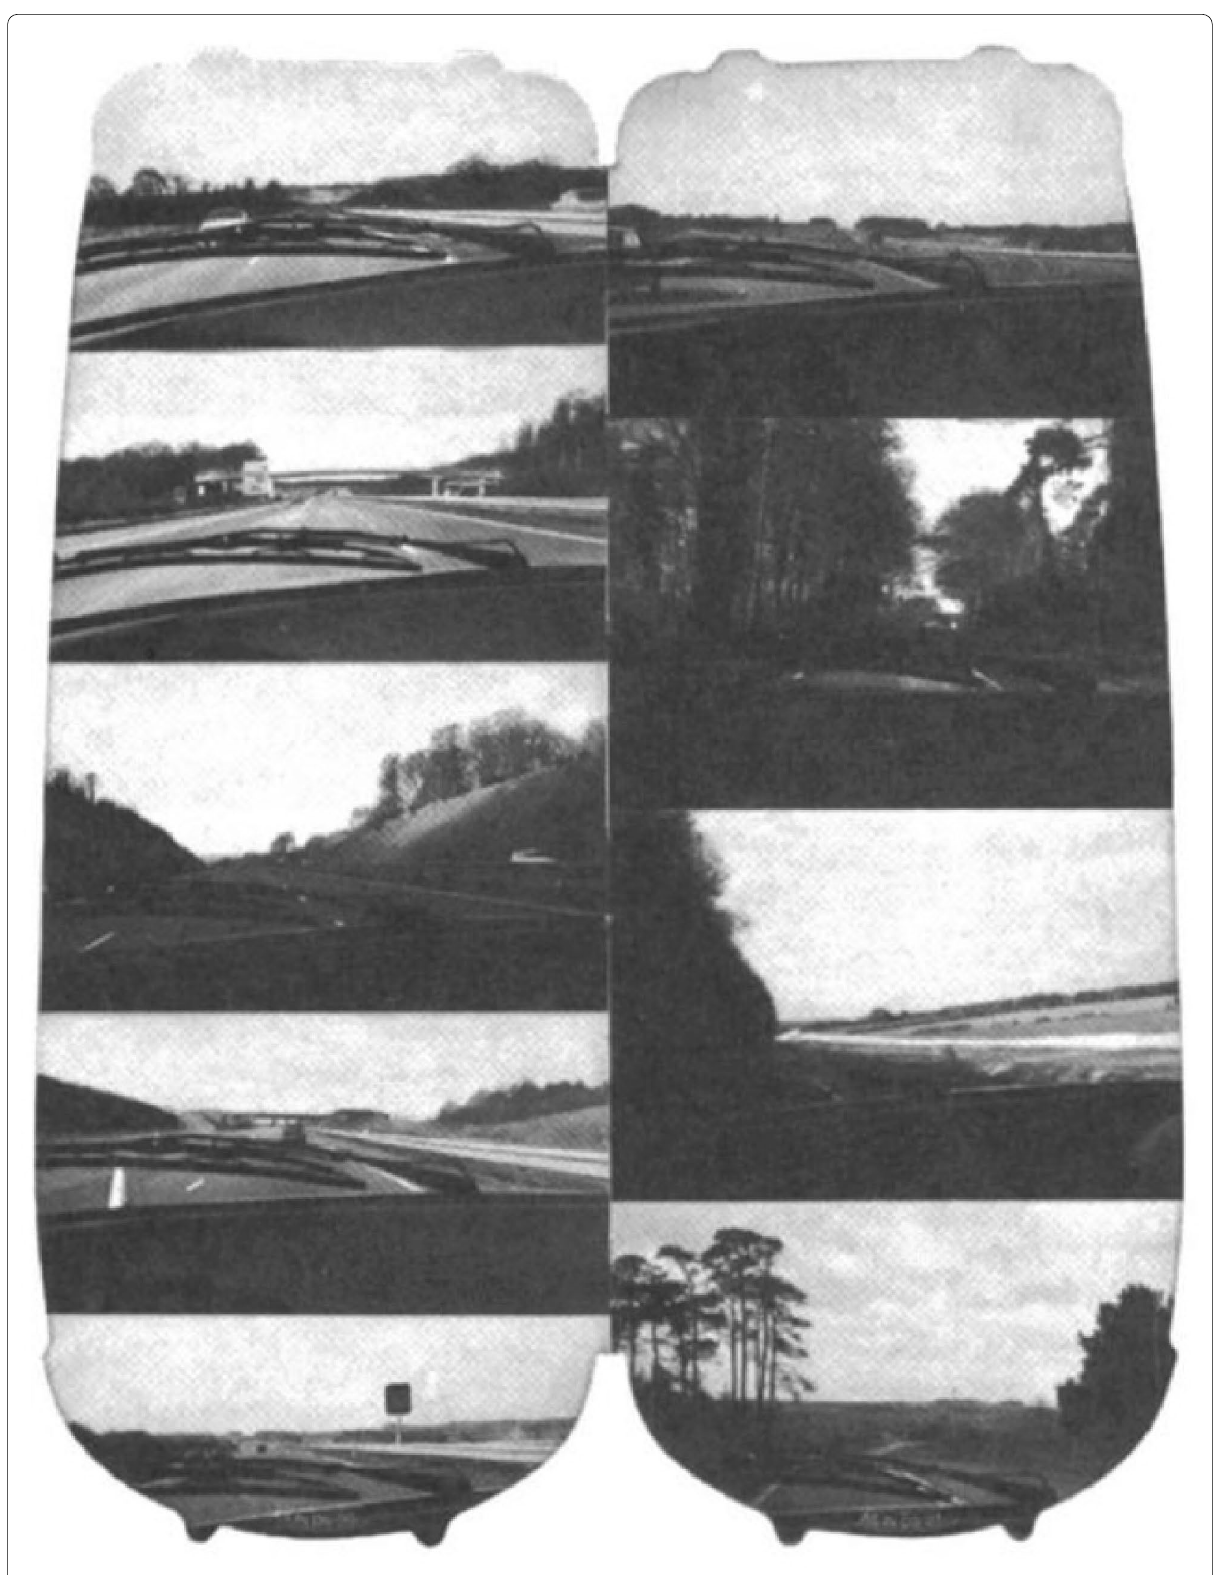
Fig. 4 Pages from Smithson (1983). Credits: Smithson Family